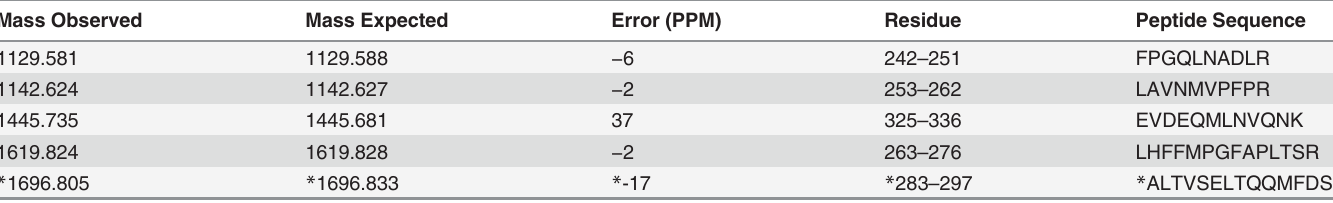
data in Table 3 are from ProFound and assigned to peptide sequence ALTVSELTQQMFDSK (data denoted with an asterisk * ). Peptide fragmentation data using LC-MS/MS suggests this assignment is incorrect and that the correct sequence is NSSYFVEWIPNNVK with deamidation at the amino- terminus yielding the sequence DSSYFVEWIPNNVK (MH+ = 1697.817 expected, 1697.813 observed, − 2.4 ppm